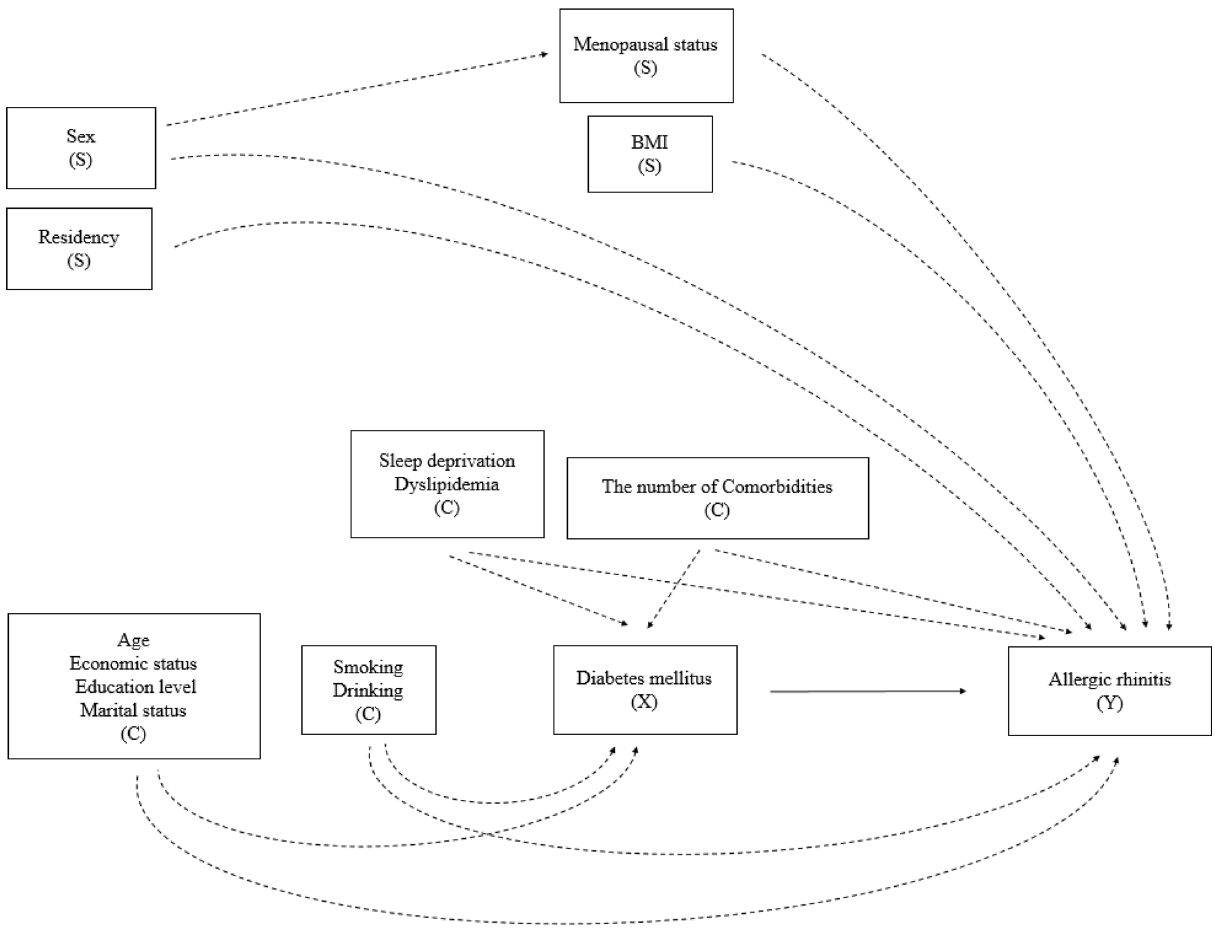
Figure 3. Assumed structure of the association regarding the effects of diabetes mellitus (DM; exposure X) with covariates (C) on allergic rhinitis (AR; outcome Y) with stratification